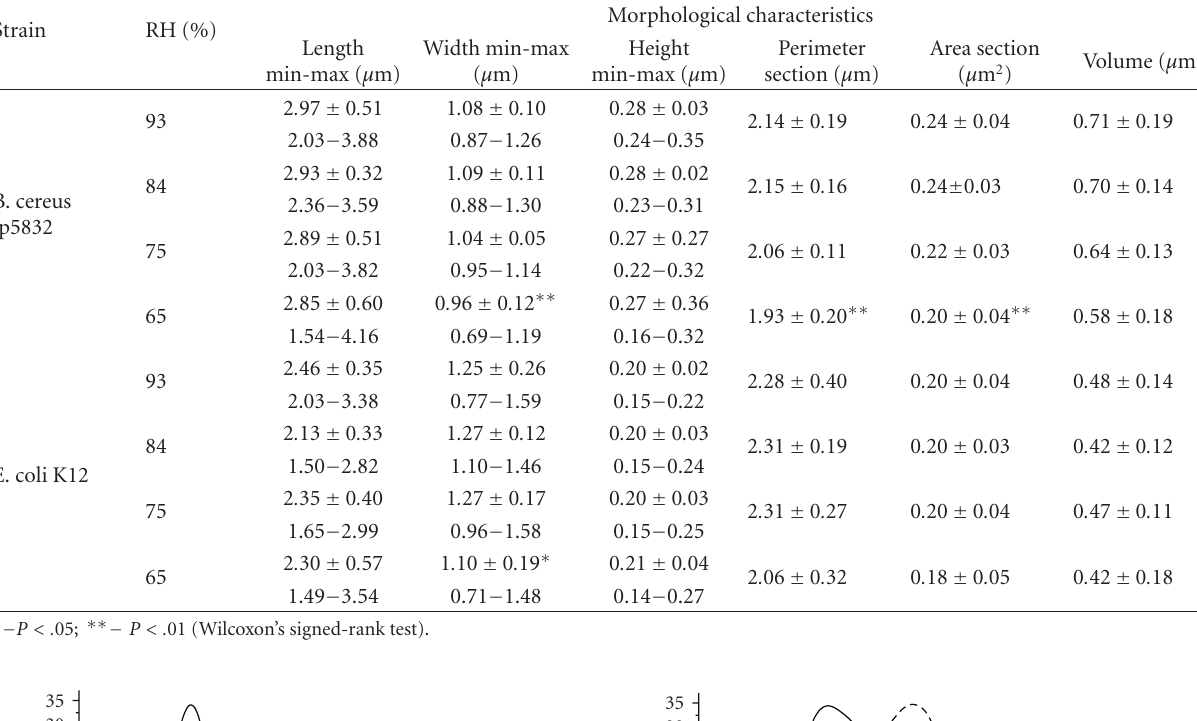
Table 1: Morphological characteristics of B. cereus and E. coli.